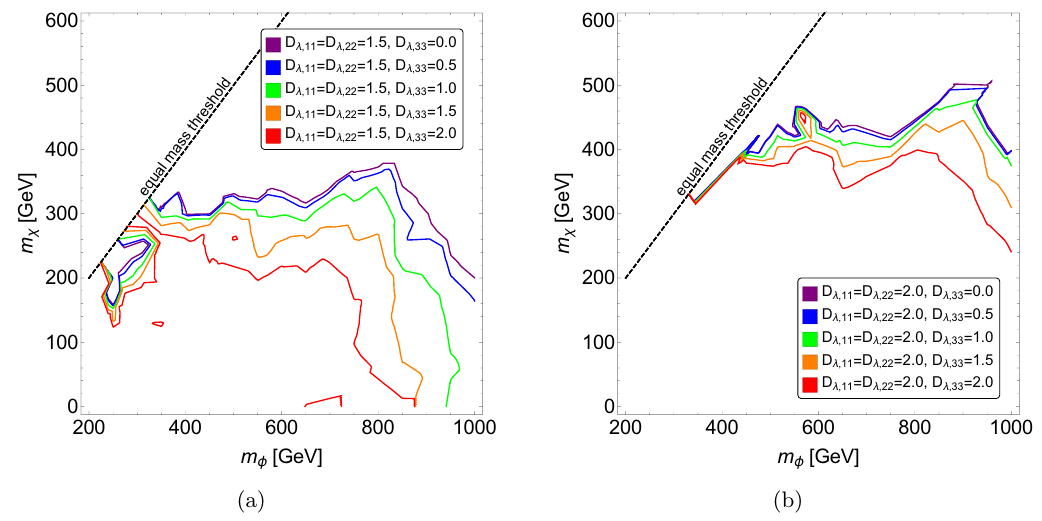
Figure 2 . Constraints on the jets + (cid:0) E T (cid:12)nal state from 8 TeV LHC run 1 data, obtained from the cross-section limits in [31]. Left: 95% C.L. exclusion contours of the quark-doublet DMFV model for various strengths of third generation couplings, with (cid:12)xed D (cid:21); 11 = D (cid:21); 22 = 1.5. Right: 95% C.L. exclusion contours of the quark-doublet DMFV model for various strengths of third generation couplings, with (cid:12)xed D (cid:21); 11 = D (cid:21); 22 = 2.0, and the mixing angles (cid:18) ij set to zero. Note that, as discussed in detail in [22], the latter do not a(cid:11)ect the identi(cid:12)ed safe parameter